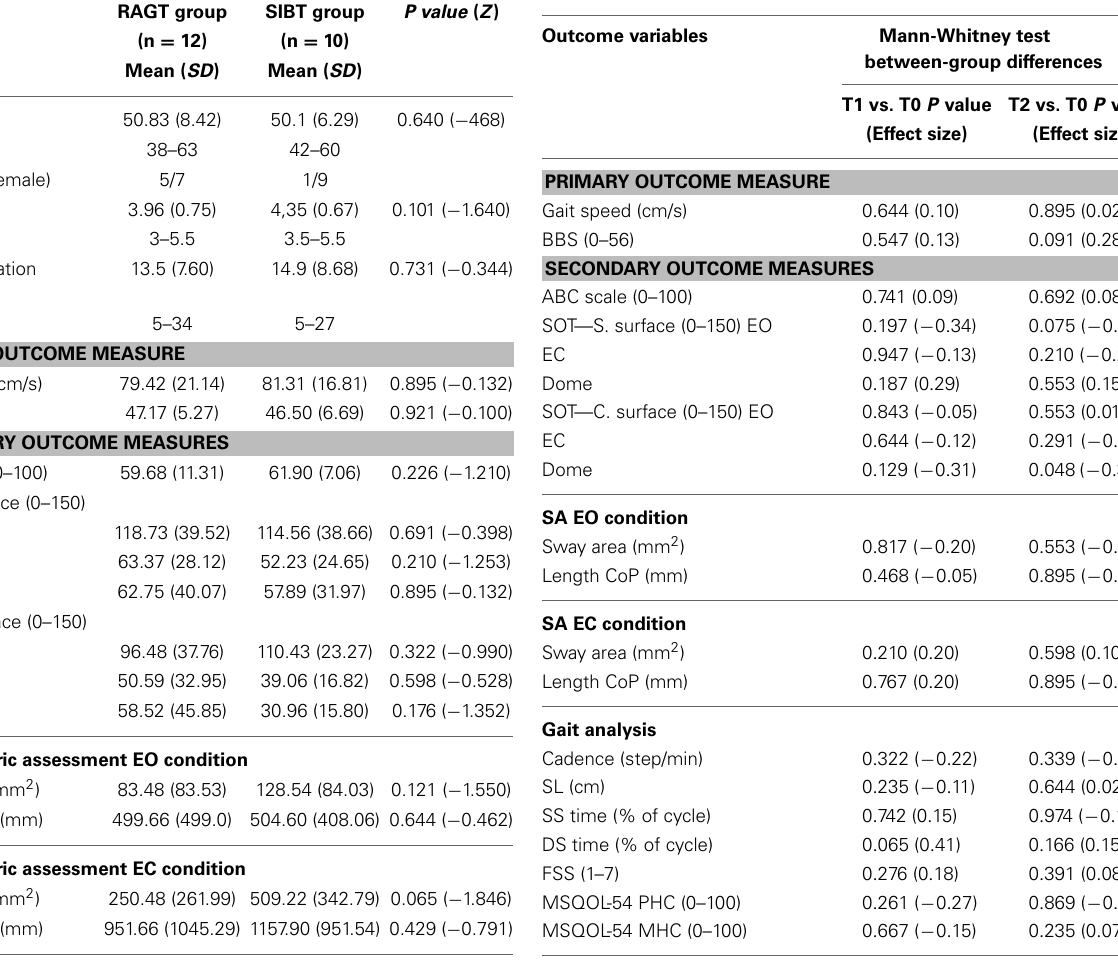
Table 1 | Baseline demographic and clinical features of the patients. Table 2 | Descriptive and inferential statistics for clinical outcome